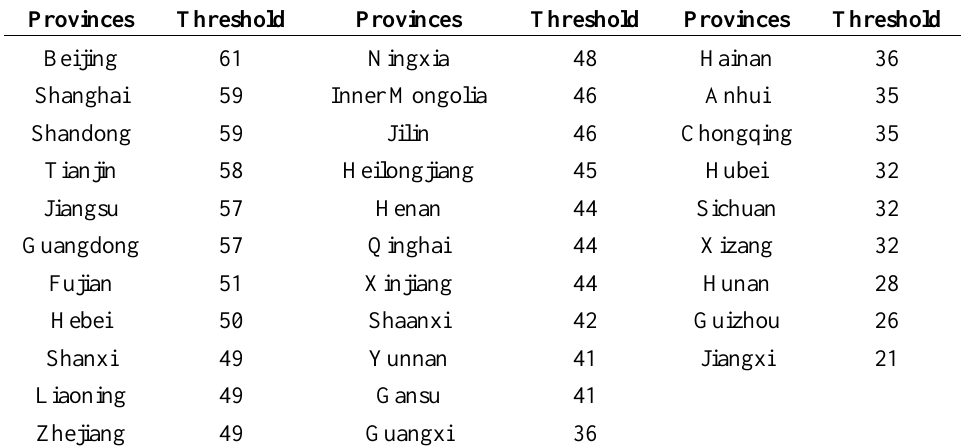
Table 2. DN thresholds for extracting built-up areas in each